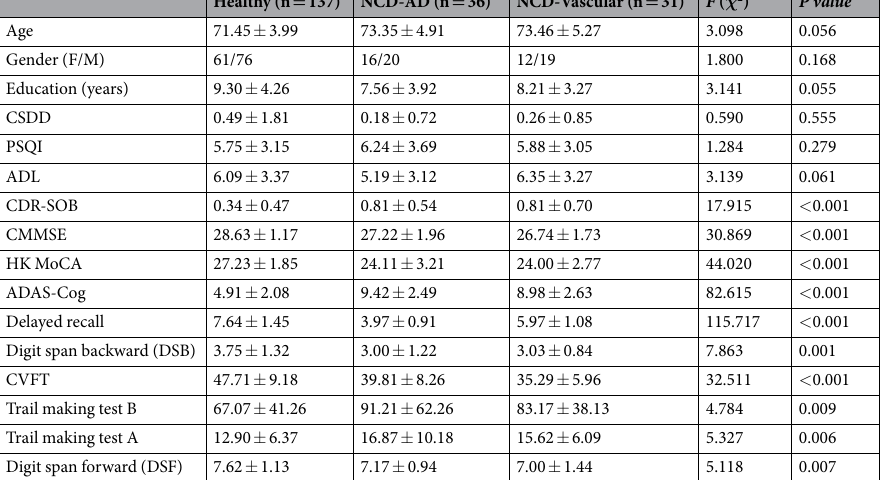
Table 1. Demographics and neurocognitive performance between healthy and NCD groups. Note. Data are raw scores and presented as mean ± SD. CSDD = The Cornell Scale for Depression in Dementia; PSQI = Pittsburgh Sleep Quality Index; ADL = Activity of daily living scale; CDR-SOB = Clinical dementia rating-sum of box; CVFT = Chinese verbal fluency test.